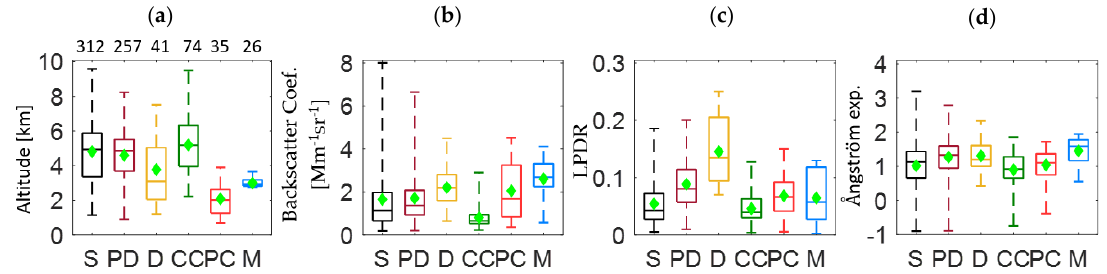
Figure 6. Aerosol layers mixtures according to ( a ) their altitude (amsl.), ( b ) β at 532 nm, ( c ) LPDR at 532 nm, ( d ) AE 532/1064 nm, related to β, for the total event (S: pure smoke layers, PD: smoke mixed with polluted dust layers, CC: smoke mixed with clean continental layers, PC: smoke mixed with polluted continental layers, D: smoke mixed with dust layers and M: smoke mixed with marine layers).